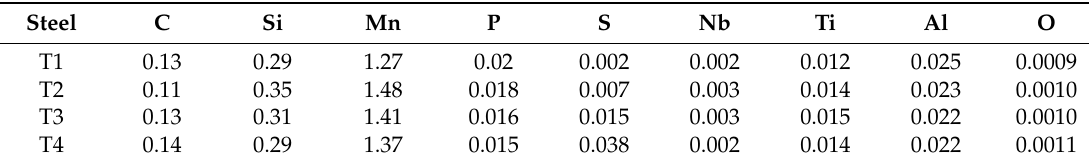
Table 1. Chemical compositions of steel samples (wt